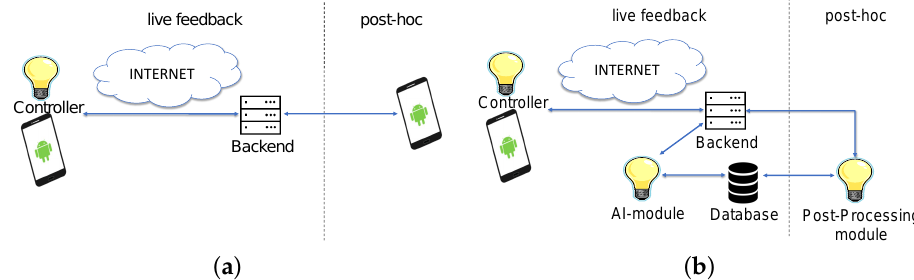
Figure 2. ( a ) Feedback provisioning on the mobile client. ( b ) Server-side feedback provisioning. Illustration of feedback provisioning within Direct Mobile Coaching. ( a ) Feedback is provided by a controller during the activity. A controller can communicate with the backend. Furthermore, after the activity, feedback can also be provided by the client and communication with the backend is